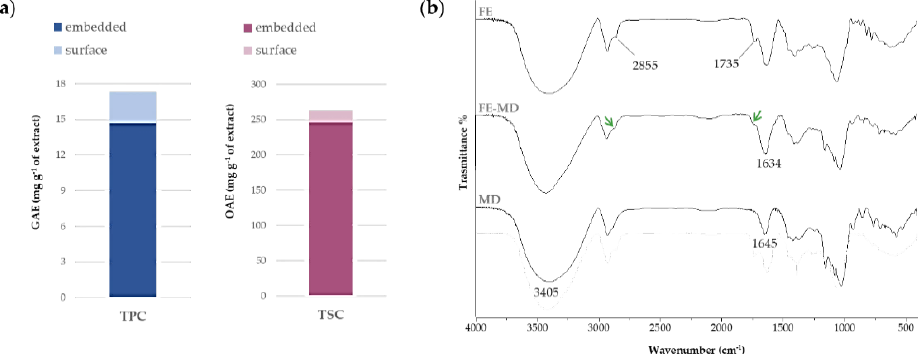
Figure 1. ( a ) Total Phenol Content (TPC), expressed as mg GAE per g of extract, and Total Saponin Content (TSC), expressed as mg OAE per g of extract. The total content of each class of compounds takes into account relative surface and embedded contents. Values are reported as the mean ± SD of three independent measurements. ( b ) FTIR spectra of floret extract (FE), floret extract encapsulated in maltodextrin (FE-MD), and pure maltodextrin (MD). Green arrows focus on CH 2 asymmetric and symmetric stretching, and estereal C=O symmetric stretching in FE-MD (please refer to the text).